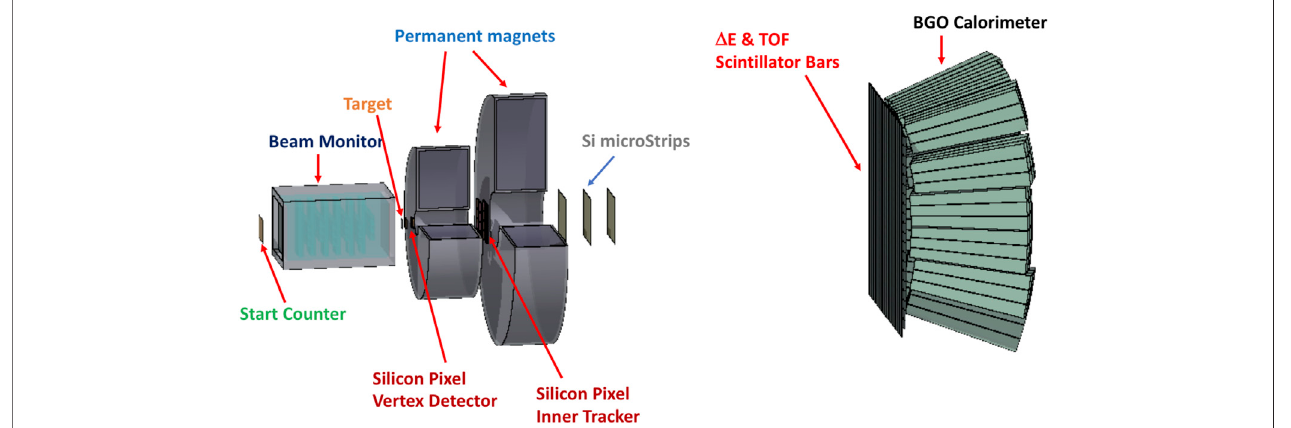
FIGURE 3 | Schematic view of the upstream region and the Magnetic Spectrometer